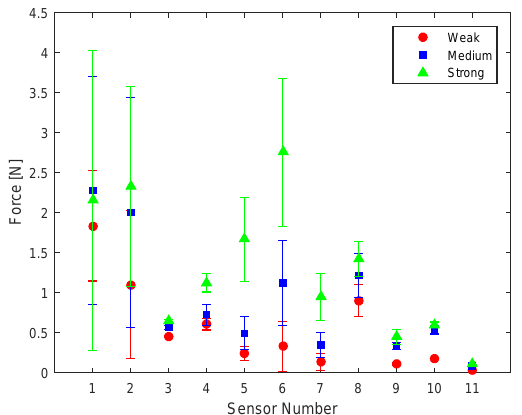
Figure 4: Average and variance of the force measured in each sen- sor for each hand grip action (best seen in color).